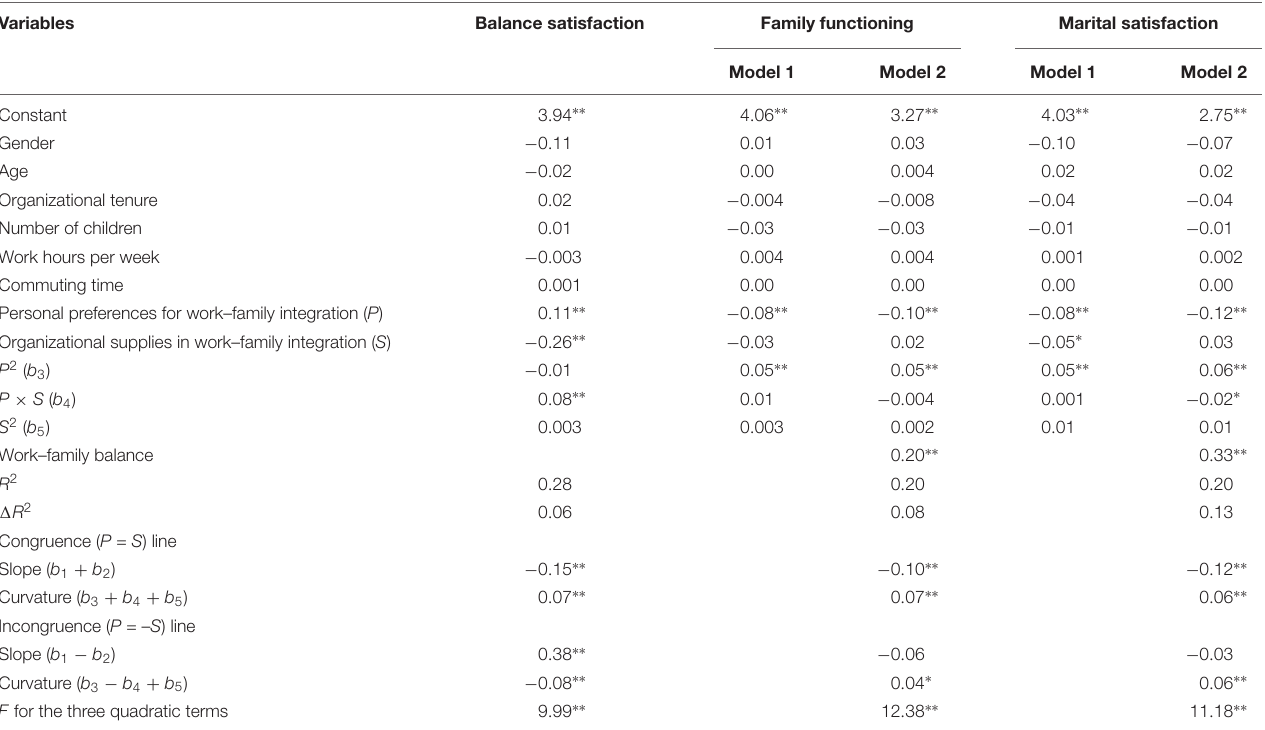
TABLE 3 | Cross-level polynomial regression results and path analysis results.